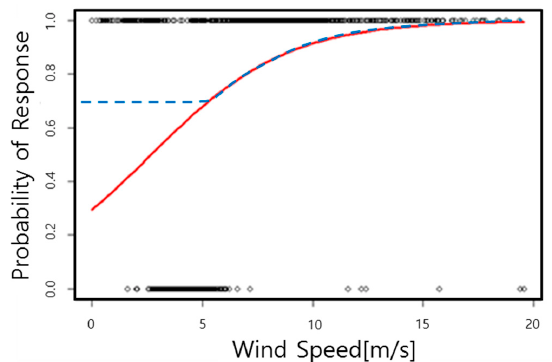
Figure 2. The statistical model for estimating reliability of power curves using logistic regression (The red line is statistical model and the blue line is fixed minimum value).